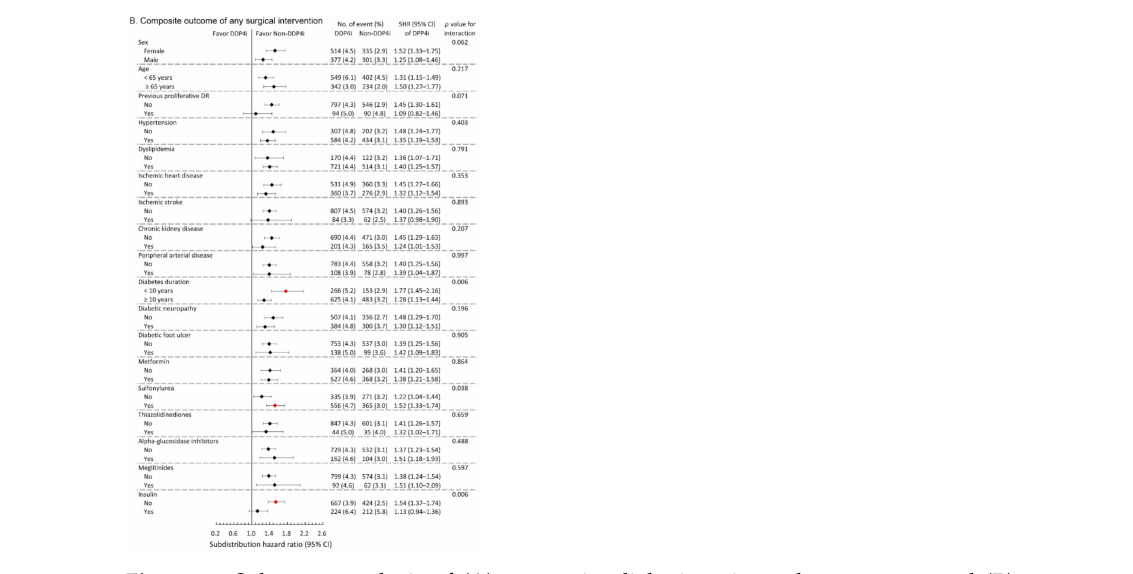
Figure 3. Subgroup analysis of ( A ) composite diabetic retinopathy outcomes and ( B ) compos- ite outcome of any surgical interventions of the diabetic patients with DR between the DPP4i users and non-DPP4i controls in the propensity score-matched cohort. The red color indicates a statistical